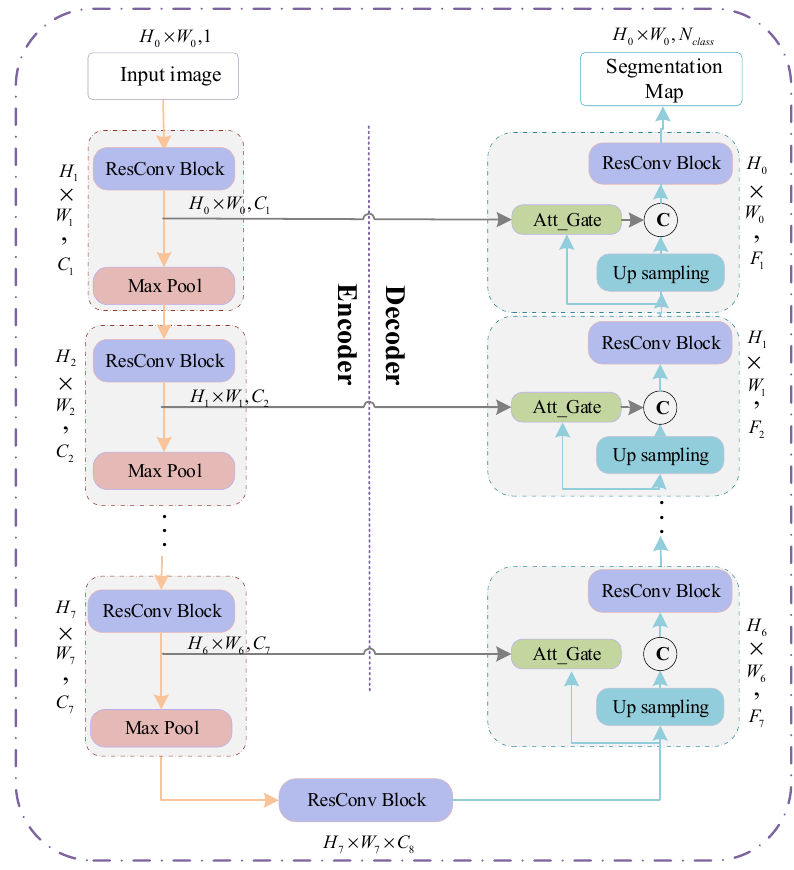
Figure 8. The architecture of RAU-Net.